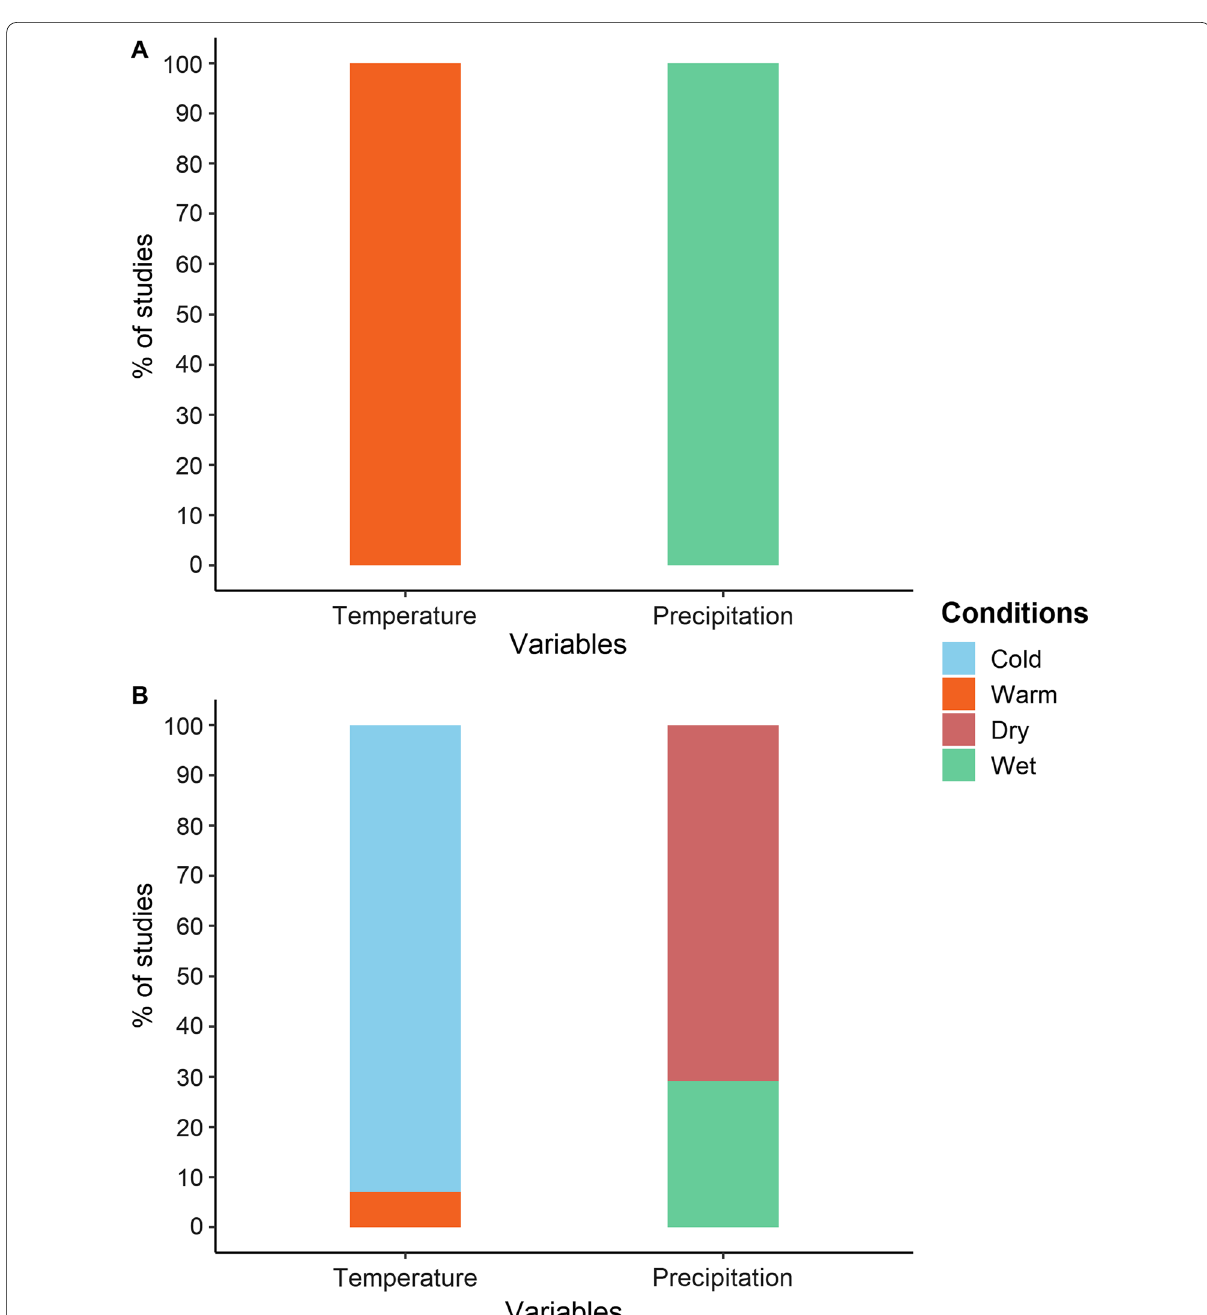
Fig. 4 Relationship of temperature and precipitation during the Last Glacial. A D–O events, B Heinrich events. The number of studies used for the warm/cold or wet/dry conditions can be found in Table